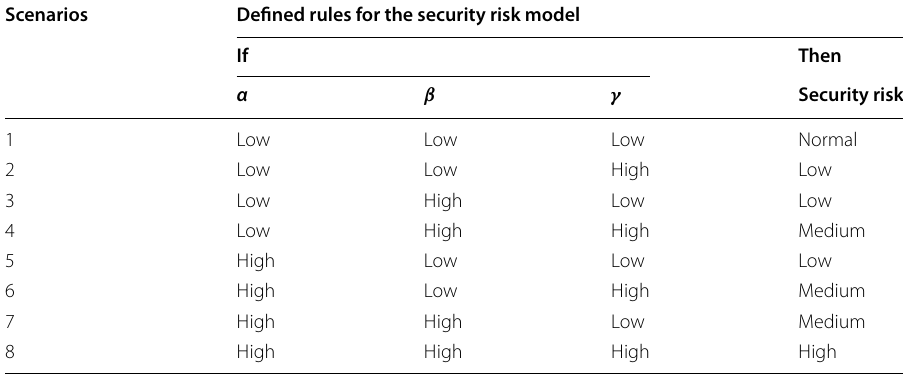
Table 1 Defined rules for α , β , and γ scenarios, and the security risks